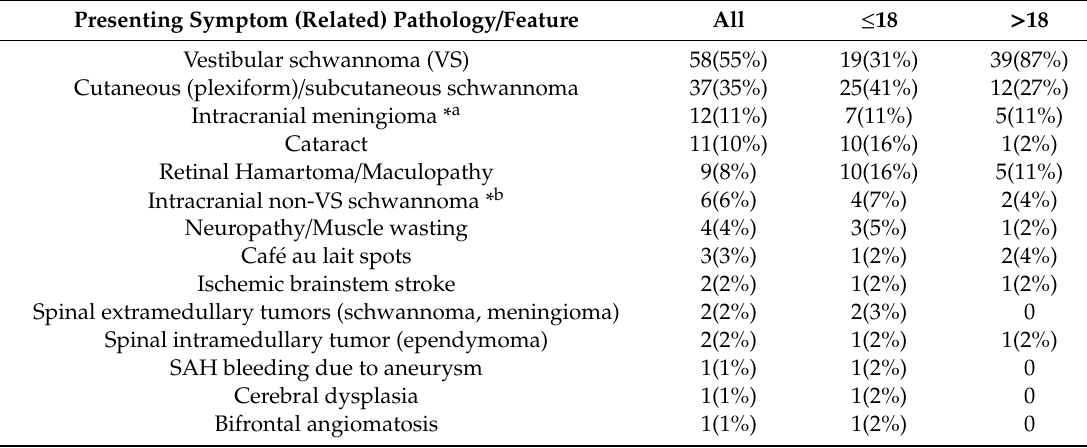
Table 3. Causal pathology for presenting symptom(s) in 100 symptomatic NF2